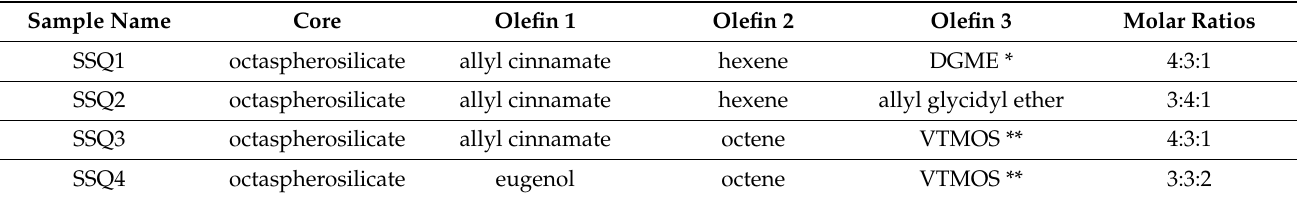
Table 1. Substrates used to perform